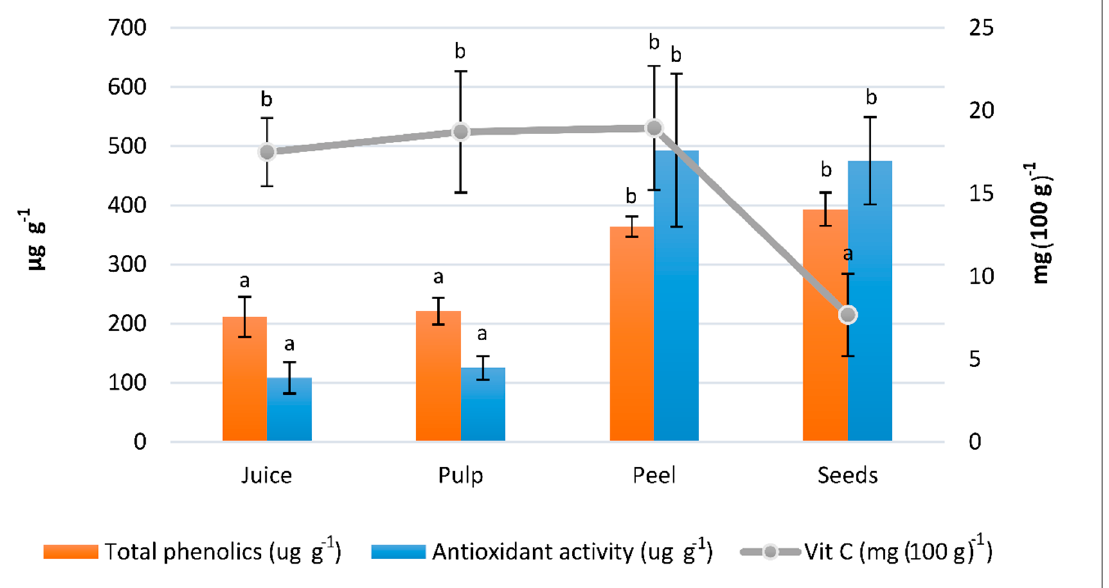
Figure 2. Total phenolics, antioxidant activity and vitamin C of melon parts. Bars are 95% confidence intervals for the mean; for a specific characteristic, values with different letters are significantly different ( p < 0.05).